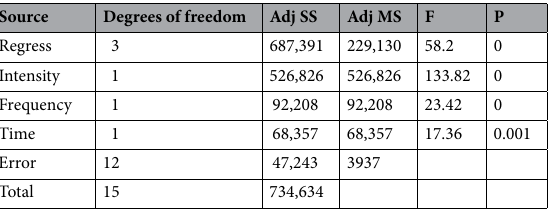
Table 6. Analysis of variance of plastic zone volume regression model. Adj SS is the adjusted sum of squares; Adj MS is the squared sum of deviations; F is the test value; P is the significant difference value.